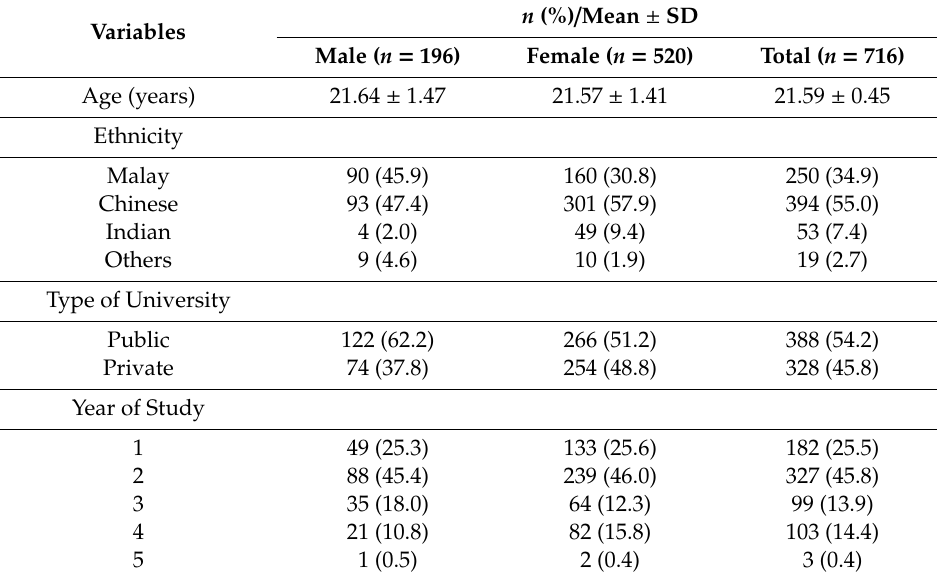
Table 1. Socio-demographic characteristics of the participants ( n =